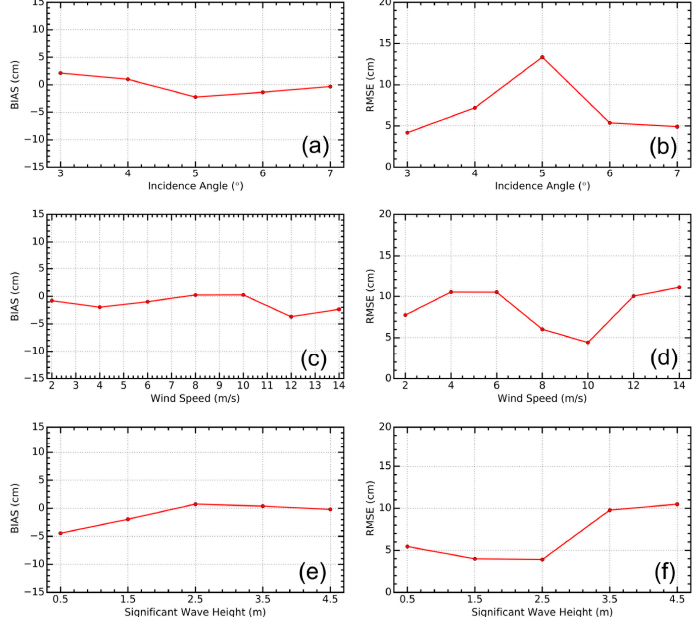
Figure 8. Error analysis after further parametric bias correction. Mean bias (BIAS) plotted against ( a ) incidence angle, ( c ) wind speed, and ( e ) significant wave height. Root mean square error (RMSE) plotted against ( b ) incidence angle, ( d ) wind speed, and ( f ) significant wave height.